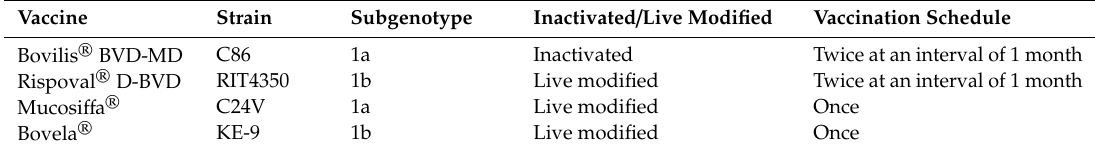
Table 1. Characteristics of vaccinal strains for commercial vaccines and vaccination design. Vaccine Strain Subgenotype Inactivated / Live Modified Vaccination Schedule Bovilis ® BVD-MD C86 1a Inactivated Twice at an interval of 1 month Rispoval ® D-BVD RIT4350 1b Live modified Twice at an interval of 1 month Mucosi ff a ® Live modified